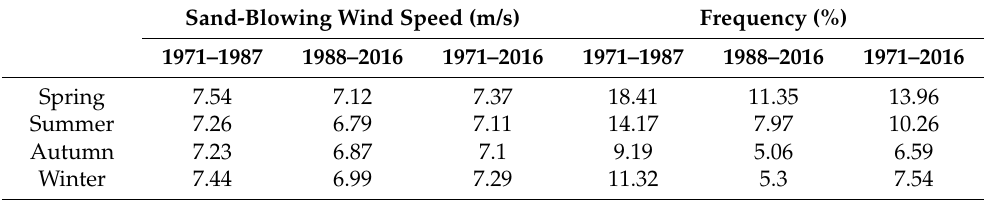
Table 2. Seasonal sand-blowing wind speed and frequency in different periods in the BJD.